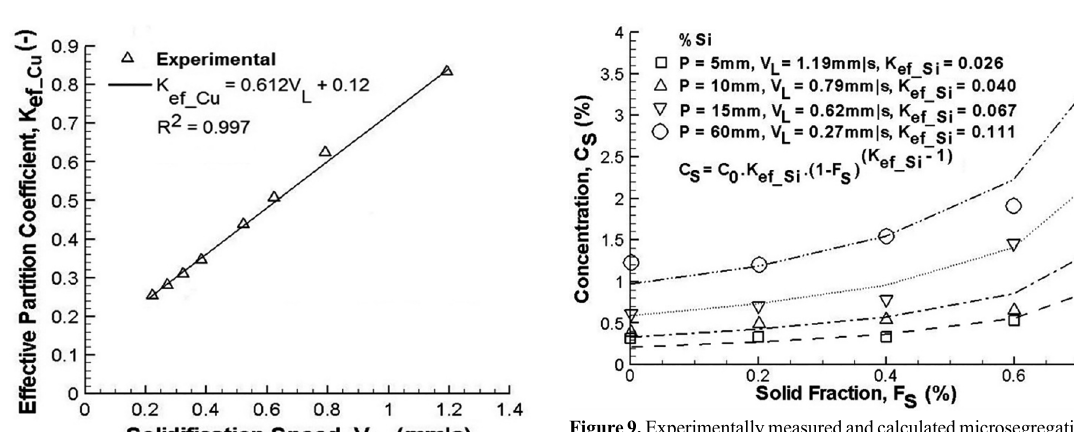
Figure 8. Effective partition coefficient ( K speed ( V ). L